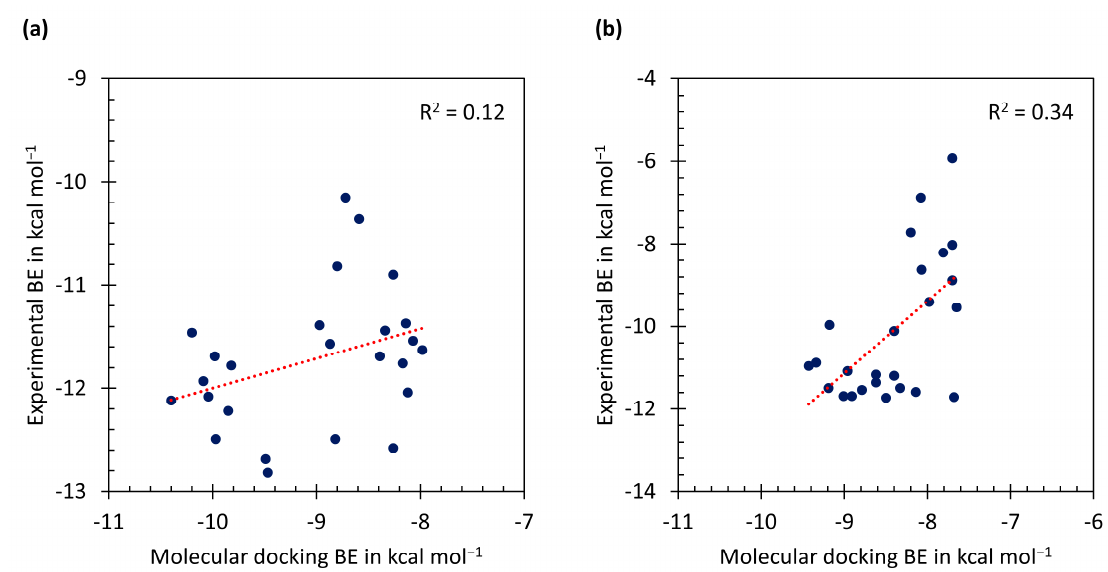
Figure 4. Plot of experimental binding energies (BE) versus molecular docking BE (Gasteiger charges) of ( a ) wild-type pf DHFR and ( b ) mutant pf DHFR.